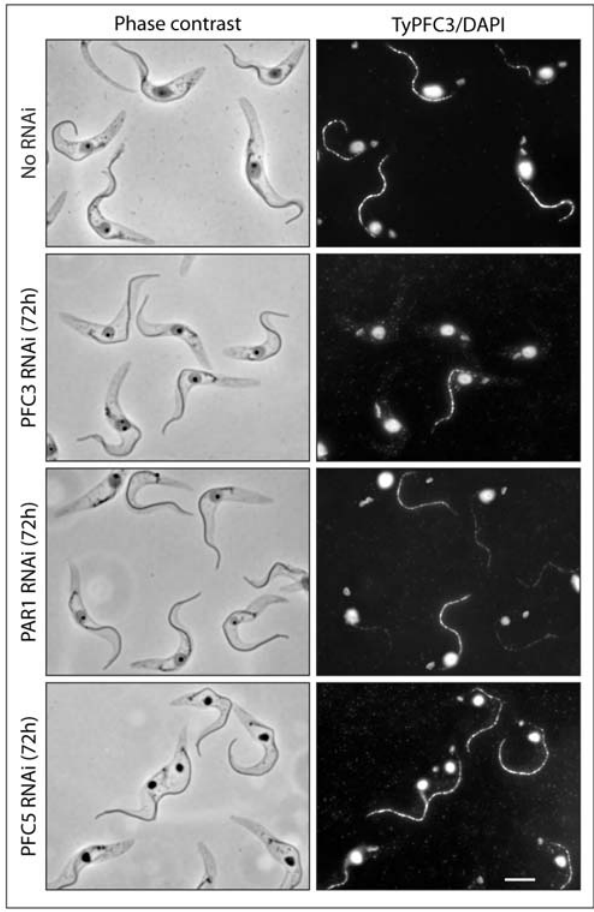
Figure 5. Immunofluorescence light microscopy of detergent extracted cells. BB2 antibody was used to detect Ty-PFC3 (flagellar signal) in PFC3, PAR1 and PFC5 RNAi environments (72 hours induction). Without RNAi induction, Ty-PFC3 is present in all flagella. After RNAi against PFC3 or PAR1, the majority of flagella no longer stain for Ty-PFC3 (it is likely that flagella that do stain represent those present prior to RNAi induction). After RNAi against PFC5, all flagella retain Ty- PFC3. DNA is visualised with DAPI. Bar–5 m m.